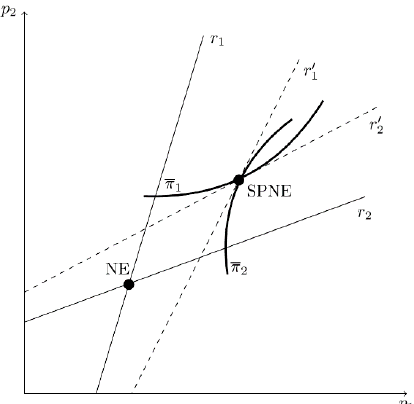
Figure 8. Owner 1’s Incentive to Hire a CEO Who Underestimates Product Substitutability in the Bertrand Model.